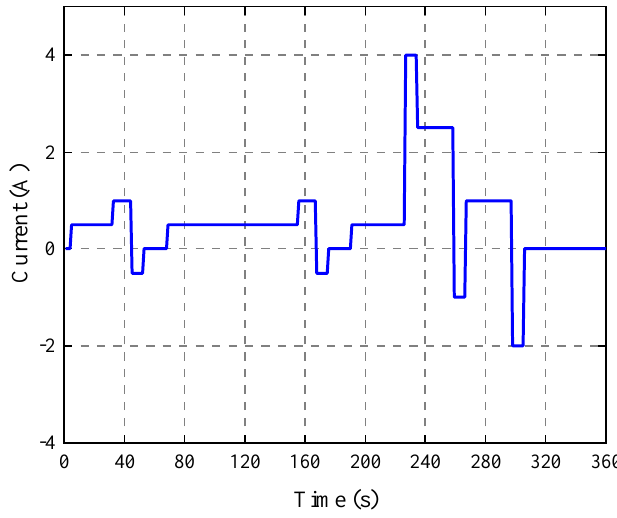
Figure 4. Current excitation curve under DST condition.